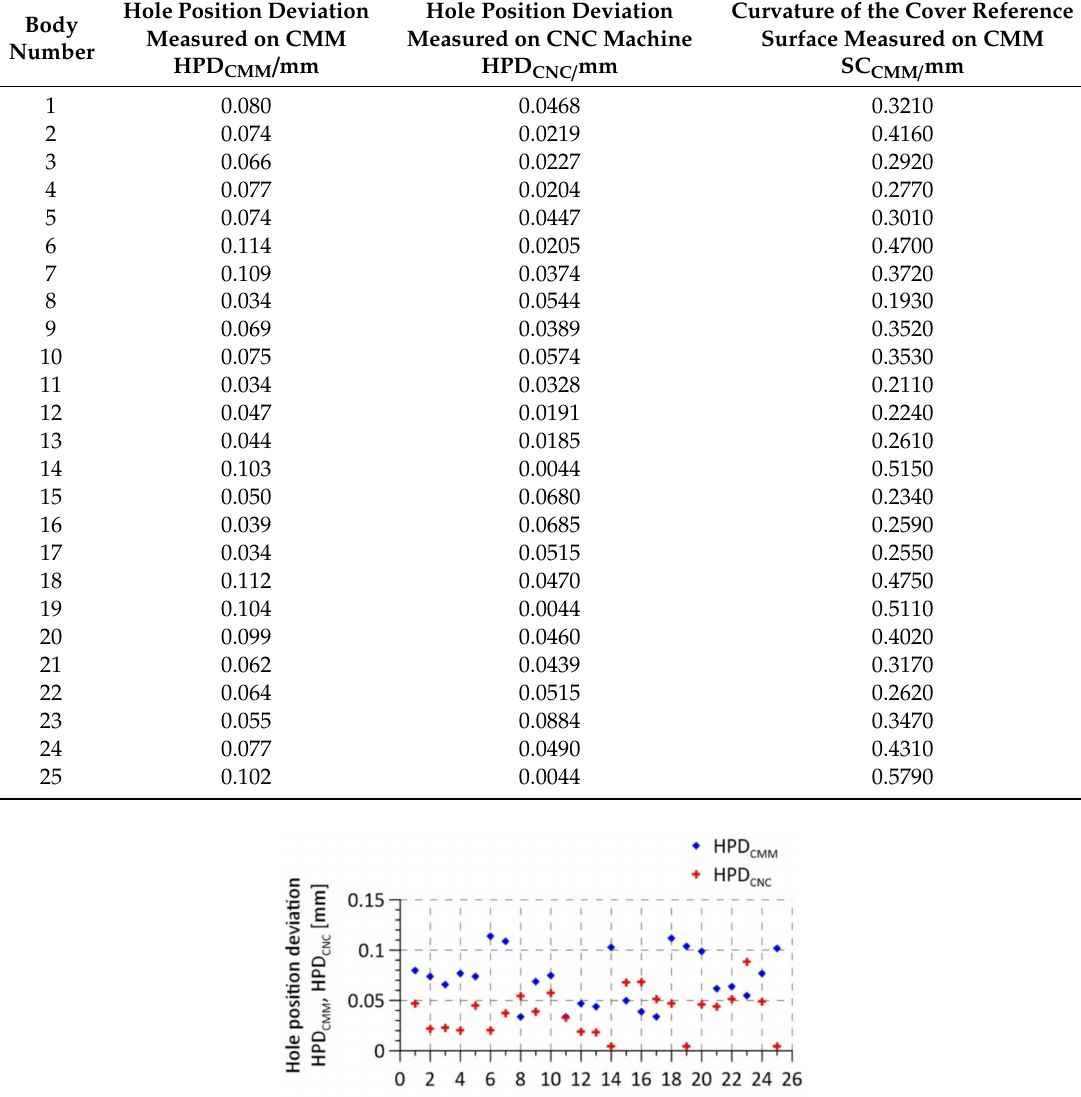
Table 1. Data from measurement systems.